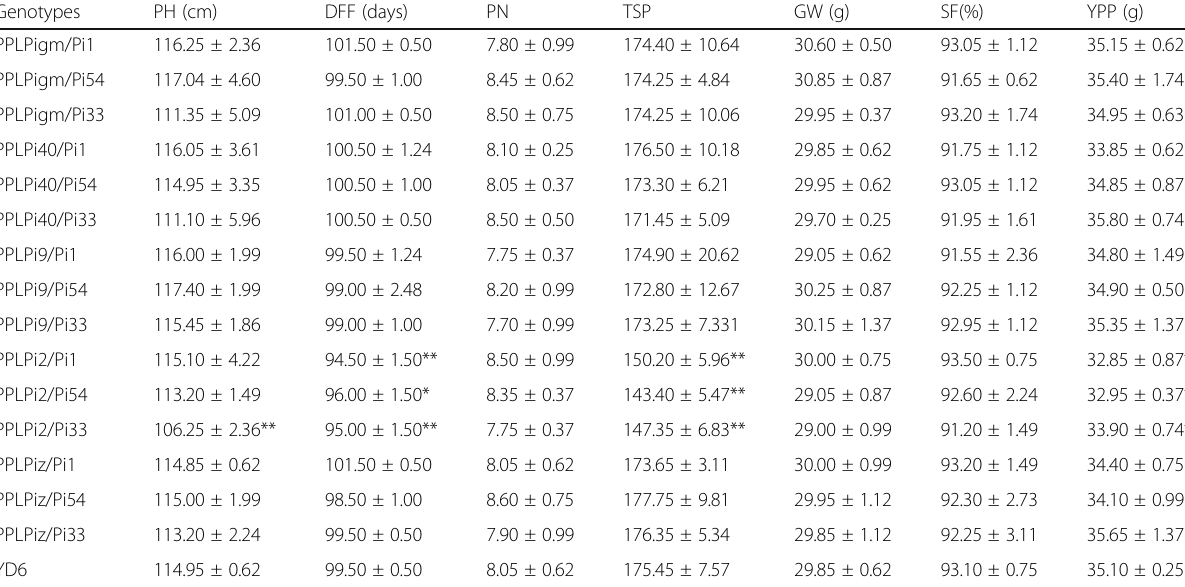
Table 2 Agronomic performance of PPLs and the recurrent parent during the summer season in 2017